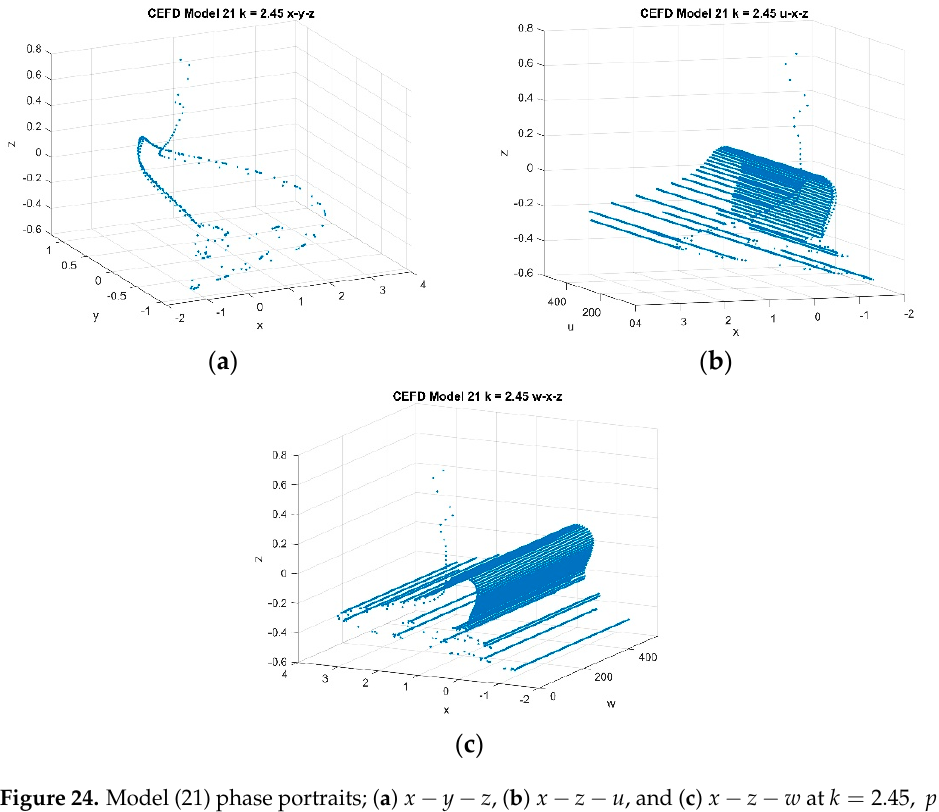
Figure 24. Model (21) phase portraits; ( a ) 𝑥 − 𝑦 − 𝑧, ( b ) 𝑥 − 𝑧 − 𝑢, and ( c ) 𝑥 − 𝑧 − 𝑤 at 𝑘 = 2.45, 𝑝 = 1, 𝛼 (cid:2873) = 0.3 .